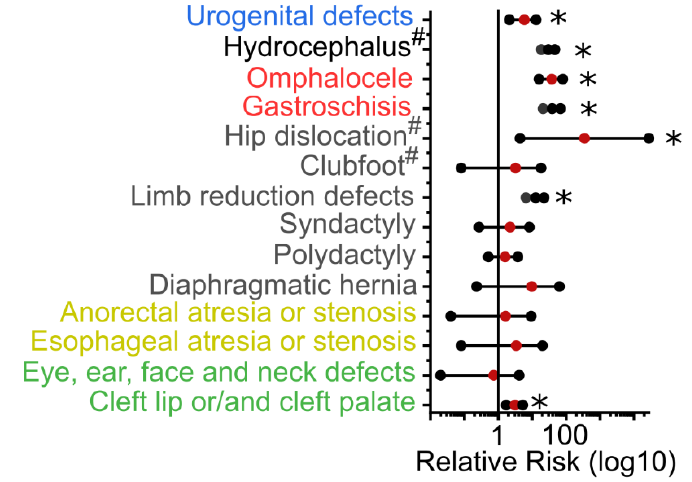
Figure 2. Relative risk of associated defects in NTDs group and non-NTDs group. # excludes cases with spina bifida. Colors group malformations related to urogenital (blue), CNS (black), body wall (red), musculoskeletal (grey), gastrointestinal (olive) and craniofacial (green) anatomy. Associations with the three NTD sub-types were also tested individually (Table 1). Cleft lip and/or palate was more commonly observed in those with spina bifida ( p < 0.01) or encephalocele ( p < 0.05) than non-NTD controls. Limb-reduction defects were more common in those with spina bifida ( p < 0.01) or anencephaly ( p < 0.01), whereas polydactyly was more common in those with encephalocele ( p < 0.01). Diaphragmatic hernias were more common in those with anencephaly ( p < 0.05). Hip dislocation was excluded from the analysis in those with spina bifida but was over-represented in those with encephalocele ( p < 0.01). Similarly, hydrocephalus was excluded from the analysis of those with spina bifida but was over-represented in those with sub-total anencephaly ( p < 0.05) and encephalocele ( p < 0.01). Omphalocele and gastroschisis were over-represented in those with either spina bifida ( p < 0.01) or anencephaly ( p < 0.01). Urogenital defects were specifically over-represented in those with spina bifida ( p < 0.01). Table 1. Associated defects in three NTDs by subtype groups and non-NTD group in five counties in Shanxi province of Northern China, 2002 – 2021.